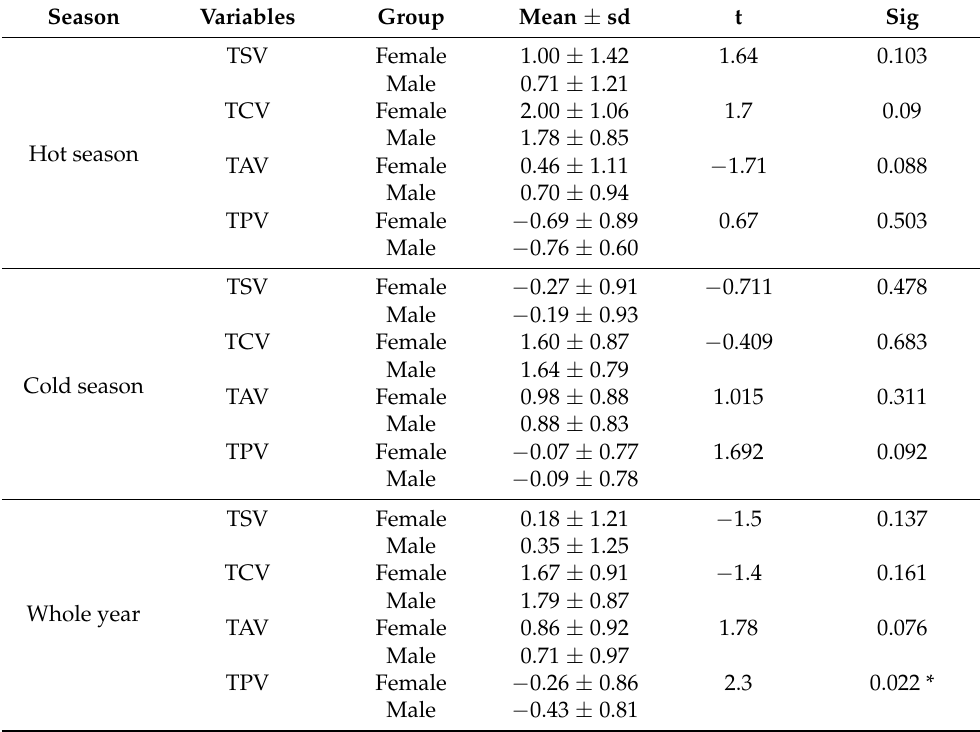
Table 8. Independent sample t -test for gender on weather perception.